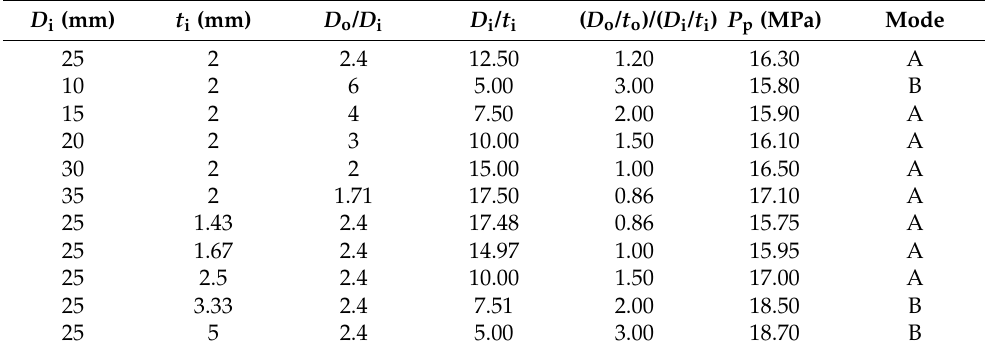
Table 7. Geometry and buckle propagation of PIP with the same outer pipe ( D o = 60 mm, t o = 4